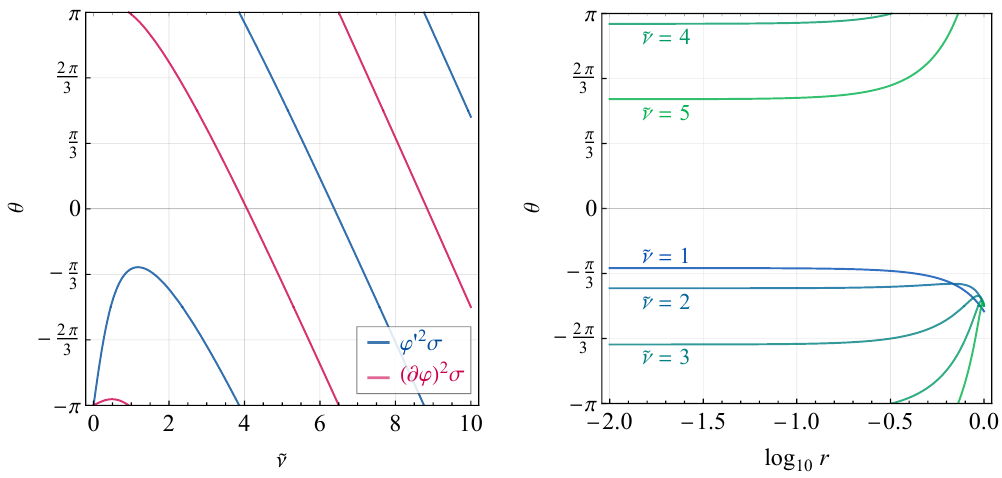
Figure 4 . The phases θ T ( r, r ) of the nonlocal signal from a tree-level exchange of a massive scalar. The left panel shows the phases in the squeezed limit r → 0 as functions of scalar mass p parameter ν = m 2 /H 2 − 9 / 4 , for both time-derivative coupling (blue) and Lorentz covariant e coupling (magenta). The right panel shows the phases from time-derivative coupling as functions of momentum ratio r , for several values of ν e